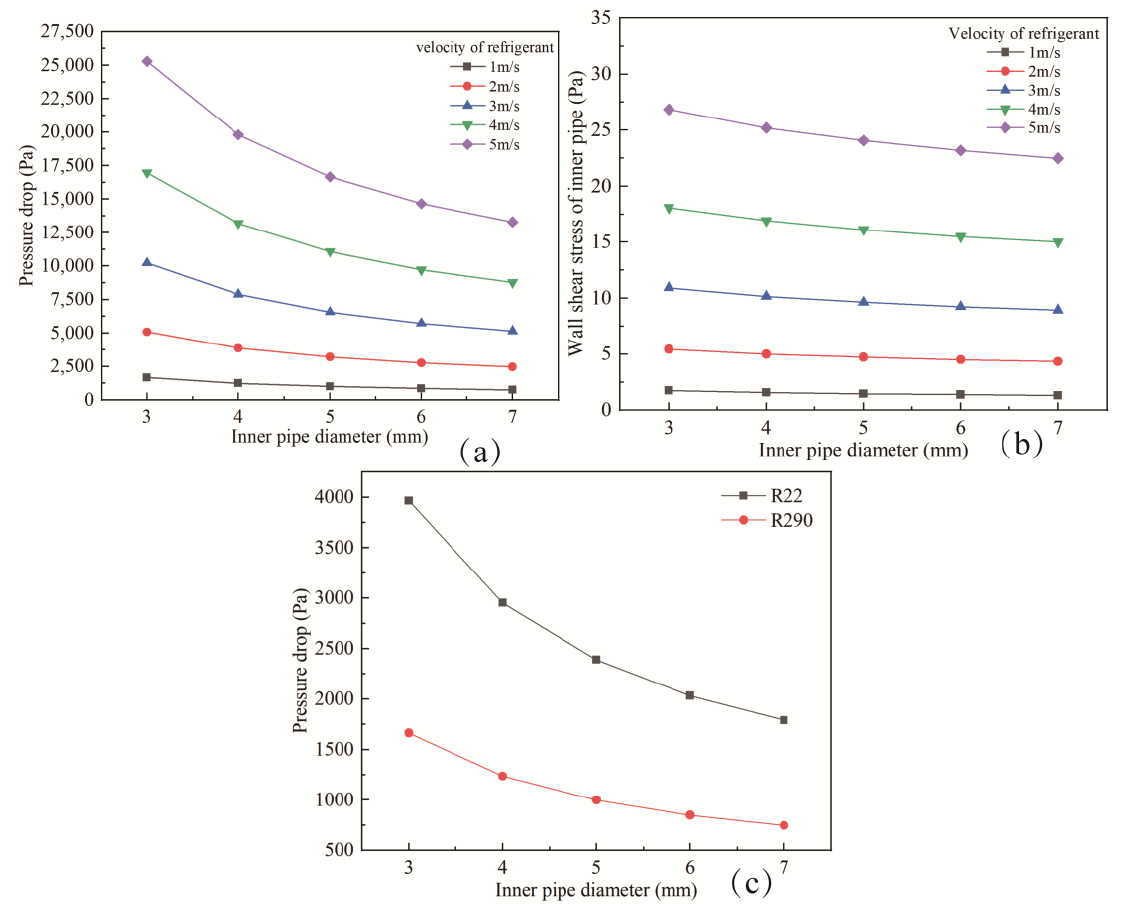
Figure 9. The impact of ( a ) inner pipe diameter on pressure drop, ( b ) wall shear stress of inner pipe and ( c ) pressure drop of R22 and R290 at different pipe diameters.